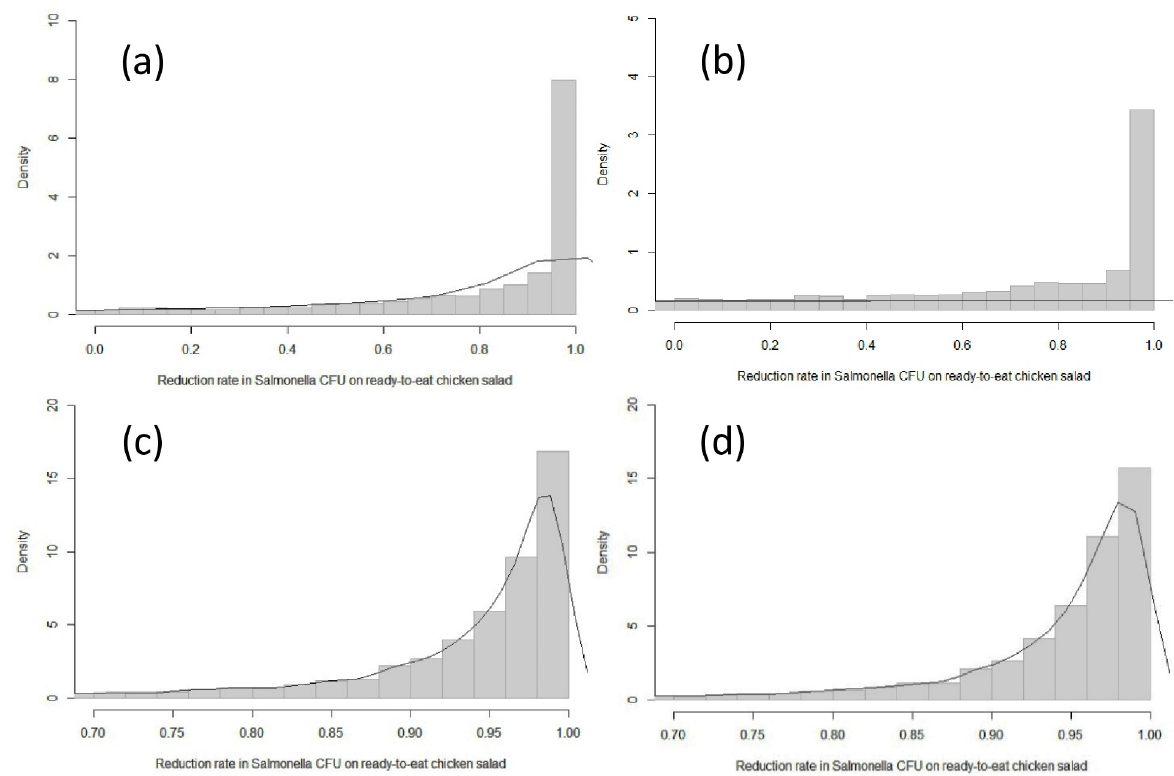
Fig 4. The reduction rate of Salmonella concentration (CFU/g) in the contaminated RTE chicken salad in Scenario 1 � (a), worst-case Scenario 1 �� (b), Scenario 2 (c) and Scenario 3 (d) based on the experiment values to bootstrap 5000 times. � Scenario 1 had only values below the initial concentration (10 CFU/g); �� Worst-case Scenario 1 included four MPN/g values (two 110 CFU/g and two 15 CFU/g), which exceeded the initial concentration (10